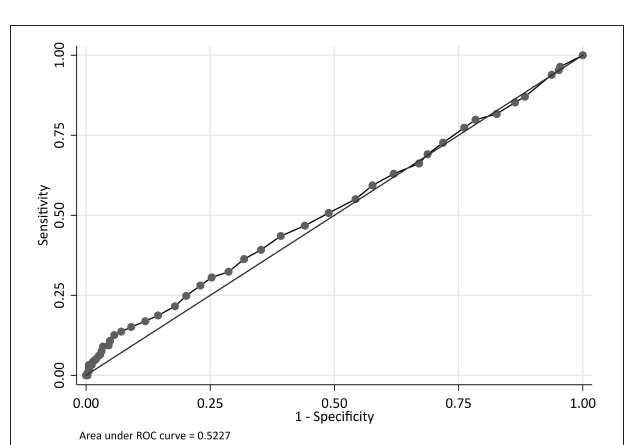
FIGURE 4 | Receiver operating characteristic (ROC) curve and Logistic regression for Pediatric Risk of Mortality Score III (PRISM III) predicting mortality.